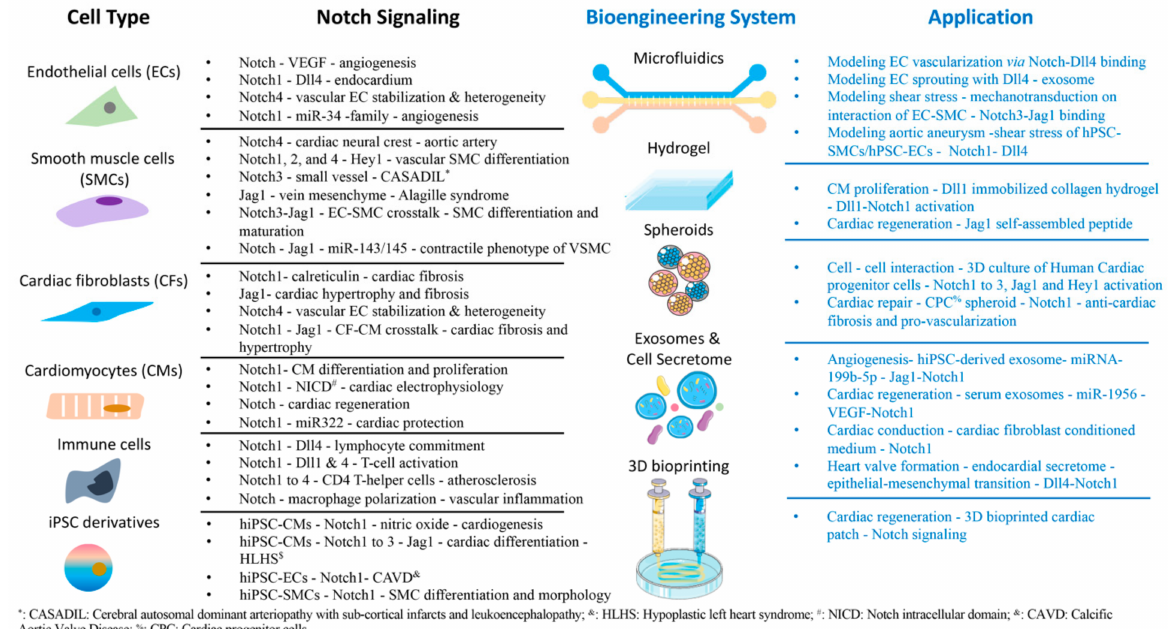
Figure 3. The pivotal roles of Notch signaling in varied cardiovascular cells with bioengineering